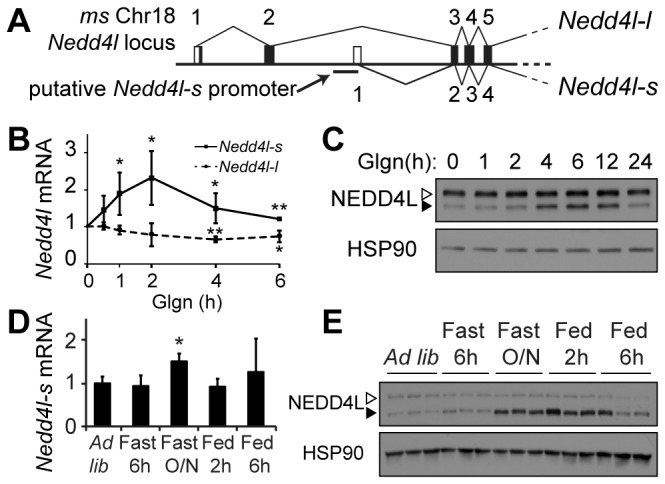

Nedd4l short isoform is induced by glucagon in primary hepatocytes and during fasting in mouse liver.(A) Diagram of the first several exons of the mouse Nedd4l locus on chromosome 18. Exons incorporated into Nedd4-long and Nedd4l-short transcripts are indicated by connected lines and numbered above and below the DNA, respectively. The putative alternate promoter for Nedd4l-short is shown. Only the first several exons are shown; the rest are shared by the two transcripts. (B) Primary mouse hepatocytes were treated with glucagon (100nM) for the indicated time (h) for analysis of Nedd4l isoform mRNA expression. mRNA amounts are normalized to Gapdh, represented as mean fold change from 0 h treatment ±stdev. *p<0.05, **p<0.01 to 0 h. (C) NEDD4L proteins and HSP90 loading control in primary hepatocytes treated as in (B). (D) Nedd4l-short mRNA from liver tissue of ad
libitum fed, fasted (6 h or overnight ‘O/N’) or O/N fasted and re-fed (2 and 6 h) male C57Bl6/J mice (n=3 per condition). Mean fold change to ad
lib, *p<0.05 to ad
lib, 6 h fasted and 2h re-red. All other combinations were not significant. (E) NEDD4L proteins and HSP90 from liver tissue as in (D). Filled arrowheads, NEDD4L-short; open arrowheads, NEDD4L-long. See Figure S1A, S1D for quantification of western blots.